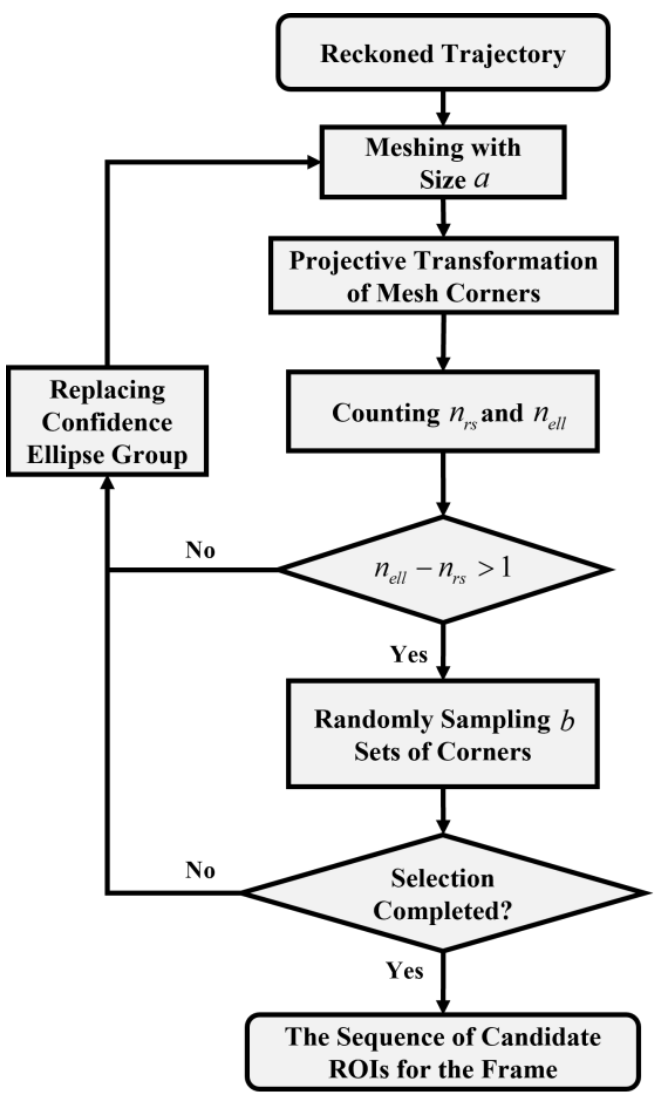
Figure 8. Flow chart of candidate ROIs extraction in the confidence ellipse region. After obtaining candidate ROIs, inspired by virtual sensing theory, a fusion method based on improved DSET is designed. A virtual sensor is a unique form of sensor, which outputs the required measurement information based on the established mathematical and statistical analysis model. The measurements derived from the mathematical model are defined as outputs of virtual sensors [27]. The candidate ROIs extracted in each frame are regarded as virtual sensors. The measurement information is defined as the predicted probability of each road surface condition output by the calibrated road feature classification model. Based on the rich measurement information of road surface conditions provided by the constructed redundant virtual sensor network, the improved DSET is used to fuse them to ensure the stability and accuracy of the IFE estimation results. DSET is a data fusion method that can objectively deal with ambiguous and uncertain information. By combining the independent judgments of multiple incompatible bodies of evidence on the sub-propositions of the identification framework, more reliable conclusions can be drawn than with a single source of information